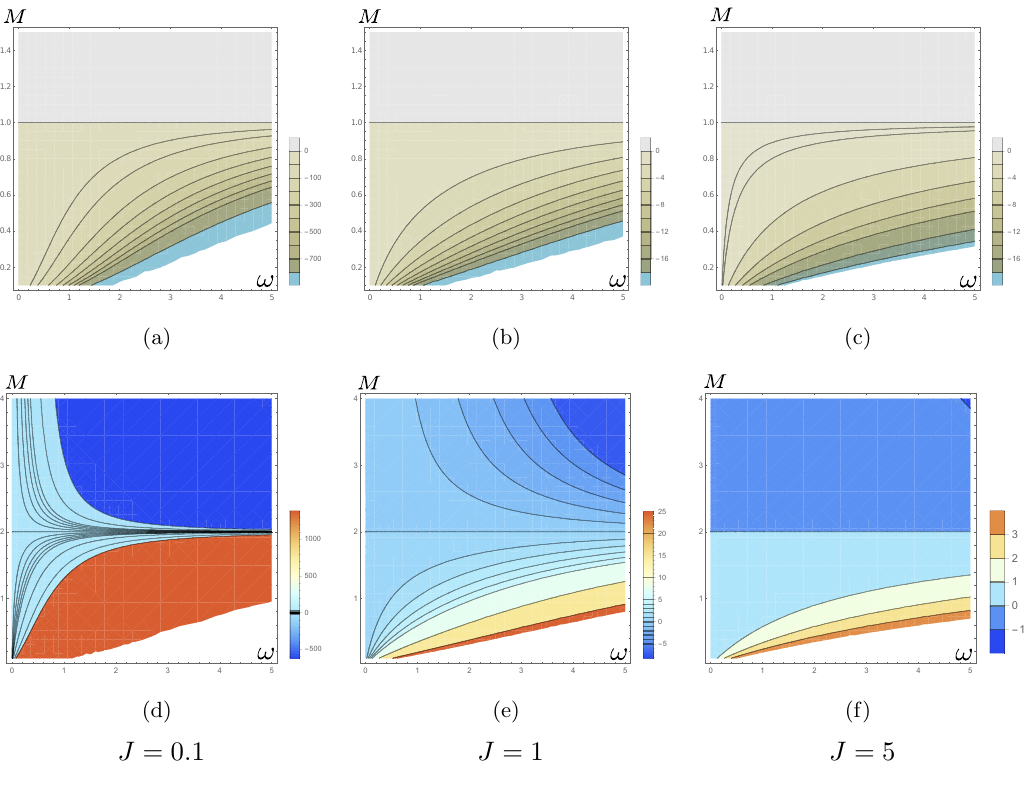
ρ (1) as a function of ω and M . The regions of −